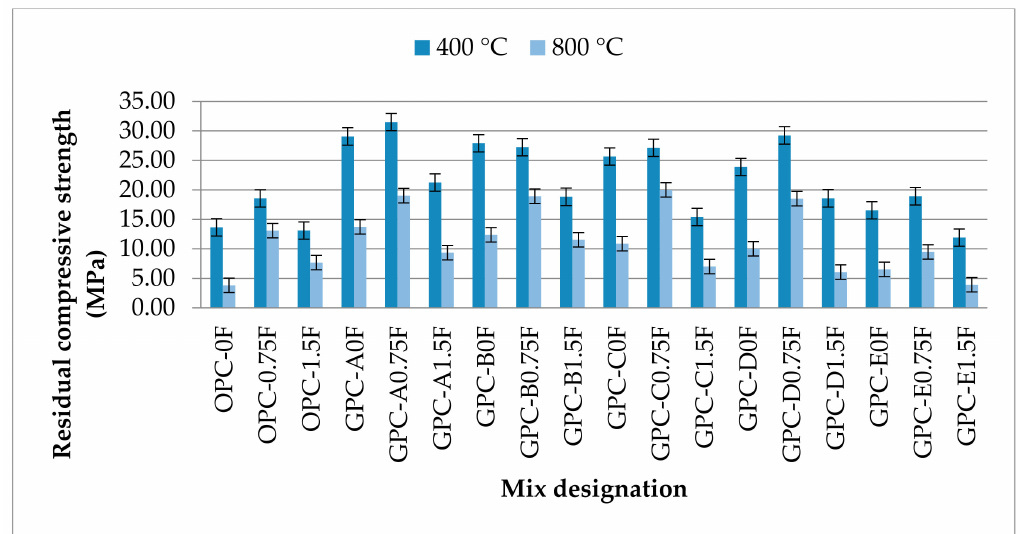
Figure 12. The residual compressive strength values of GPC and OPC mixes after heating the specimens at elevated